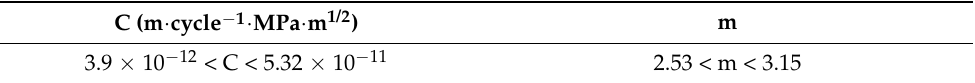
Table 2. The values of C and m parameters are based on the Paris law on C–Mn steels